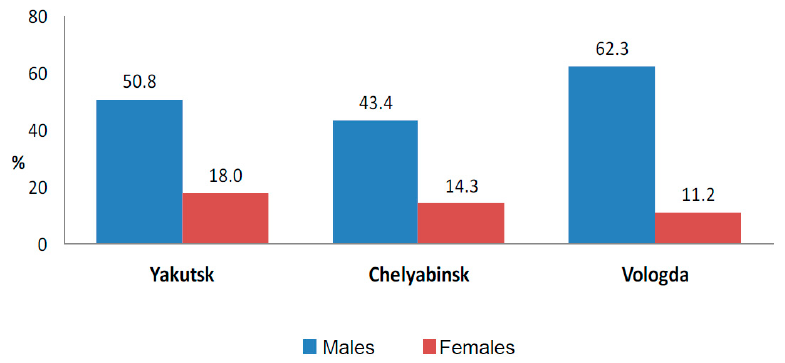
Figure 3. Prevalence of daily smoking in the studied regions.